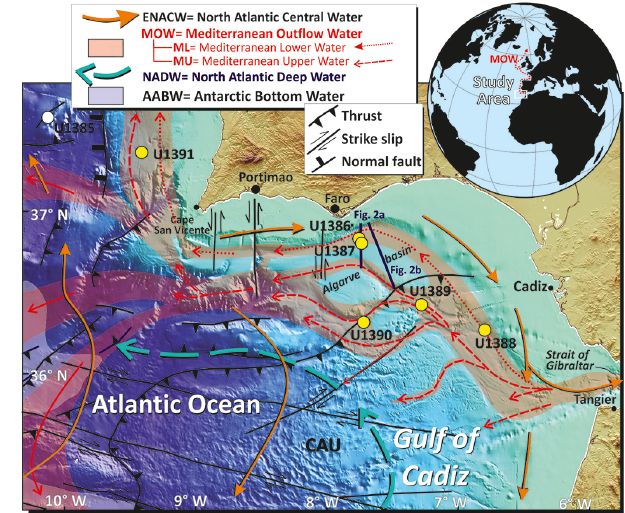
Figure 1. Expedition 339 sites in the Gulf of Cádiz and west Iberian margin, shown as yellow / white solid circles. Bottom water masses and ocean currents shown as NADW = North Atlantic deep water; AABW = Antarctic Bottom Water; ENACW = east North Atlantic common water; MOW = Mediterranean outflow water; MU, ML, AI = Atlantic